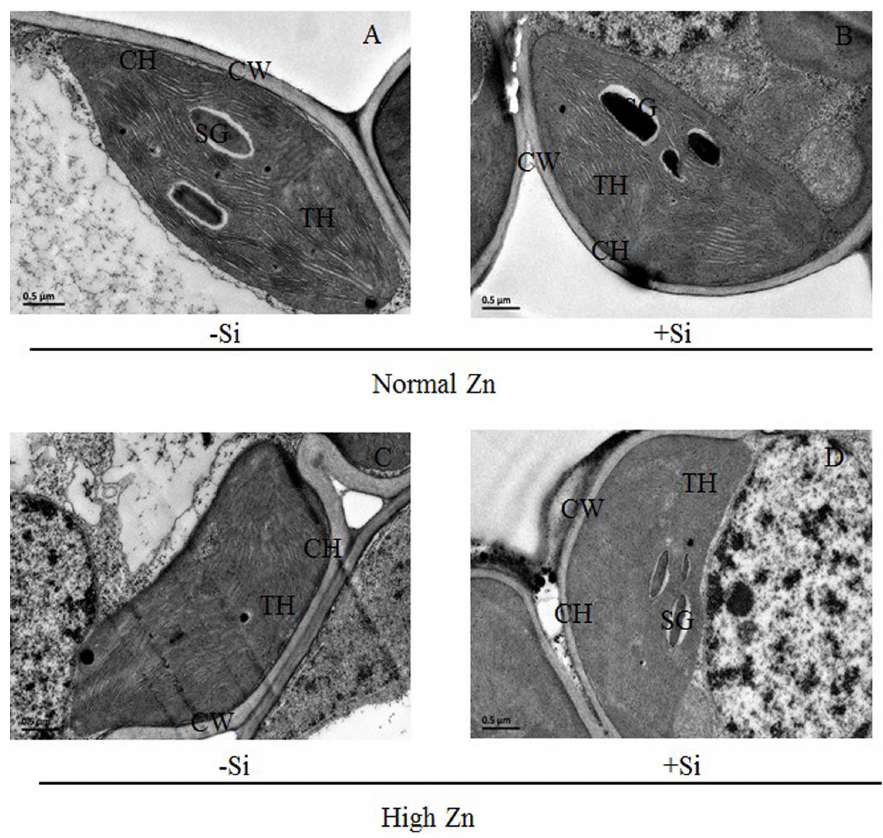
Figure 7. Chloroplast ultrastructure of Zn-sensitive rice ( Oryza sativa L.) cultivar grown hydroponically with either normal (0.15 m M) or high (2 mM) Zn without or with 1.5 mM Si for seven days. CH 5 chloroplast, CW 5 cell wall, SG 5 starch grains, P 5 plastoglobuli, TH 5 thylakoid membranes, Vac 5 vacuole.